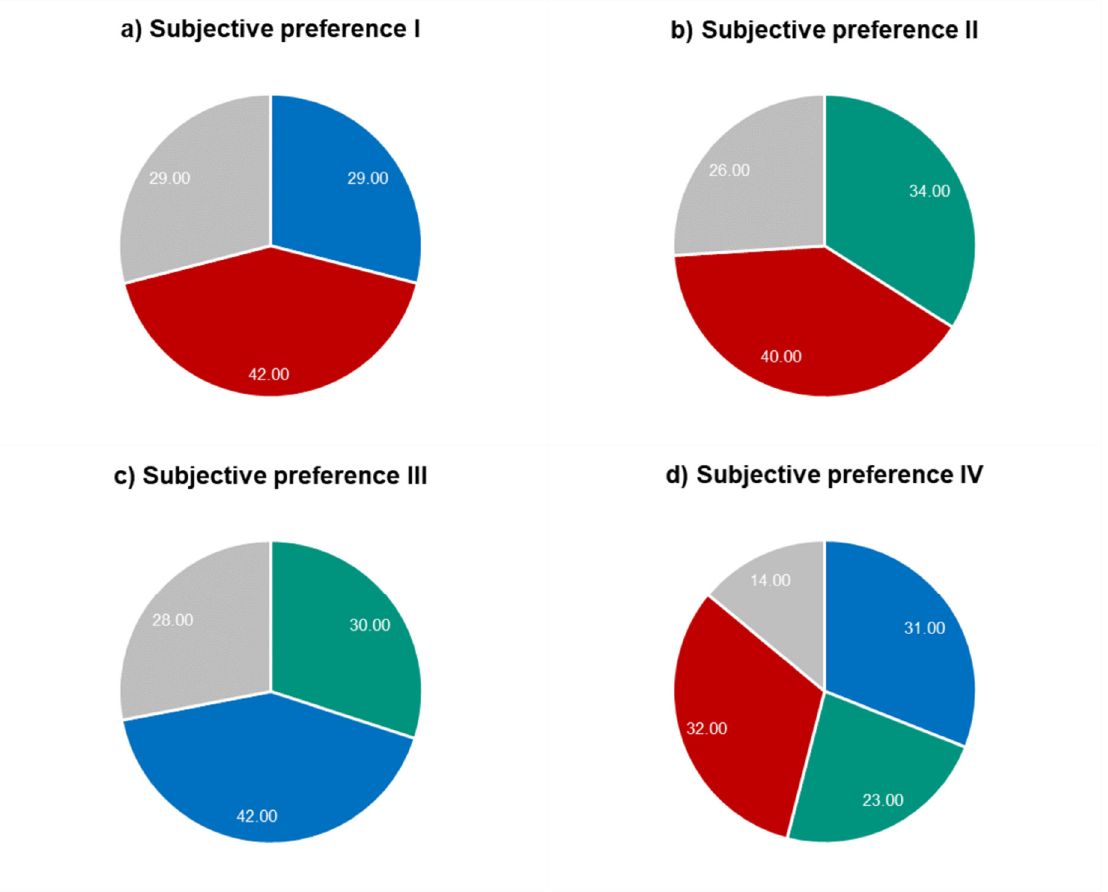
Figure 3. Subjective preferences for direct comparisons of methods (Figure 3a–c) and between methods. ( a ) Autorefraction (red) vs. Wavefront Refraction (blue), ( b ) Autorefraction (red) vs. Standard Refraction (green), ( c ) Standard Refraction (green) vs. Wavefront Refraction (blue), and ( d ) Standard Refraction (blue) vs. Wavefront Refraction (green) vs. Autorefraction (red). Gray area: no difference.